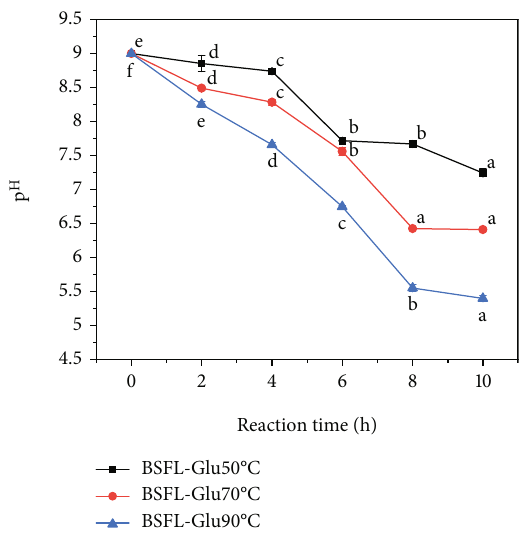
Figure 1: Changes in pH of BSFL-GLu conjugates model system as a function of reaction time. Values are mean ± standard deviation ; means with di ff erent superscript are signi fi cantly di ff erent at the same heating